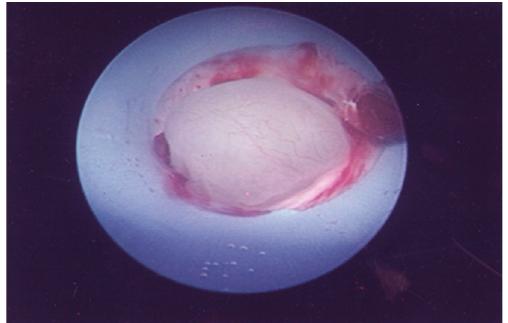
Figure 2: Macroscopic view of fibroepithelial polyp of the kidney within the nephroscopic sheath following application of the 25 mm Amplatz GOOSE NECK Snare to the polyps base.